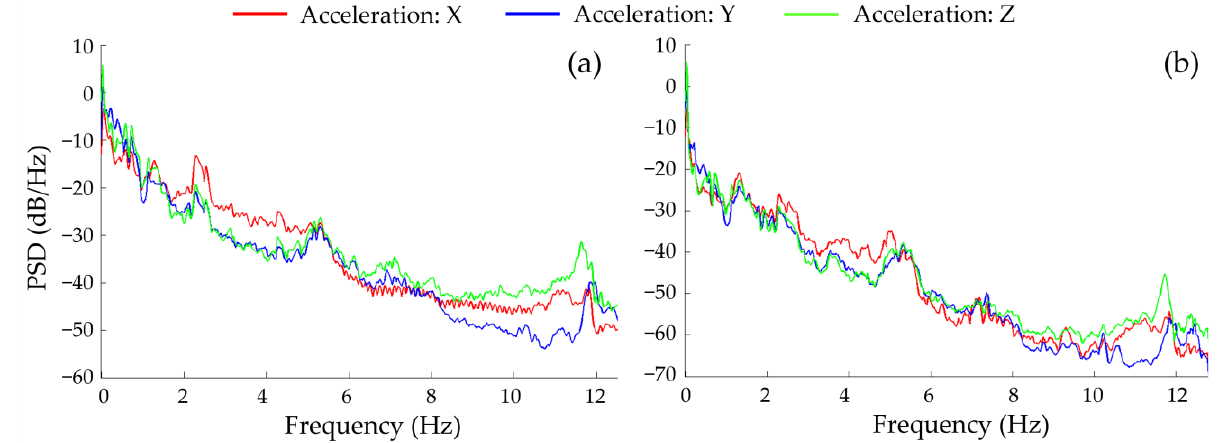
Figure 8. PSD analysis of the measured vibration on the conveyor belt for high ( a ) and low ( b ) trans- planting speed under the unloaded condition.